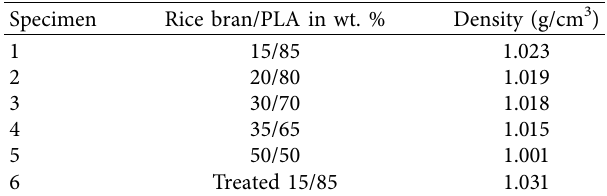
Table 4: Density test of rice bran PLA composite.